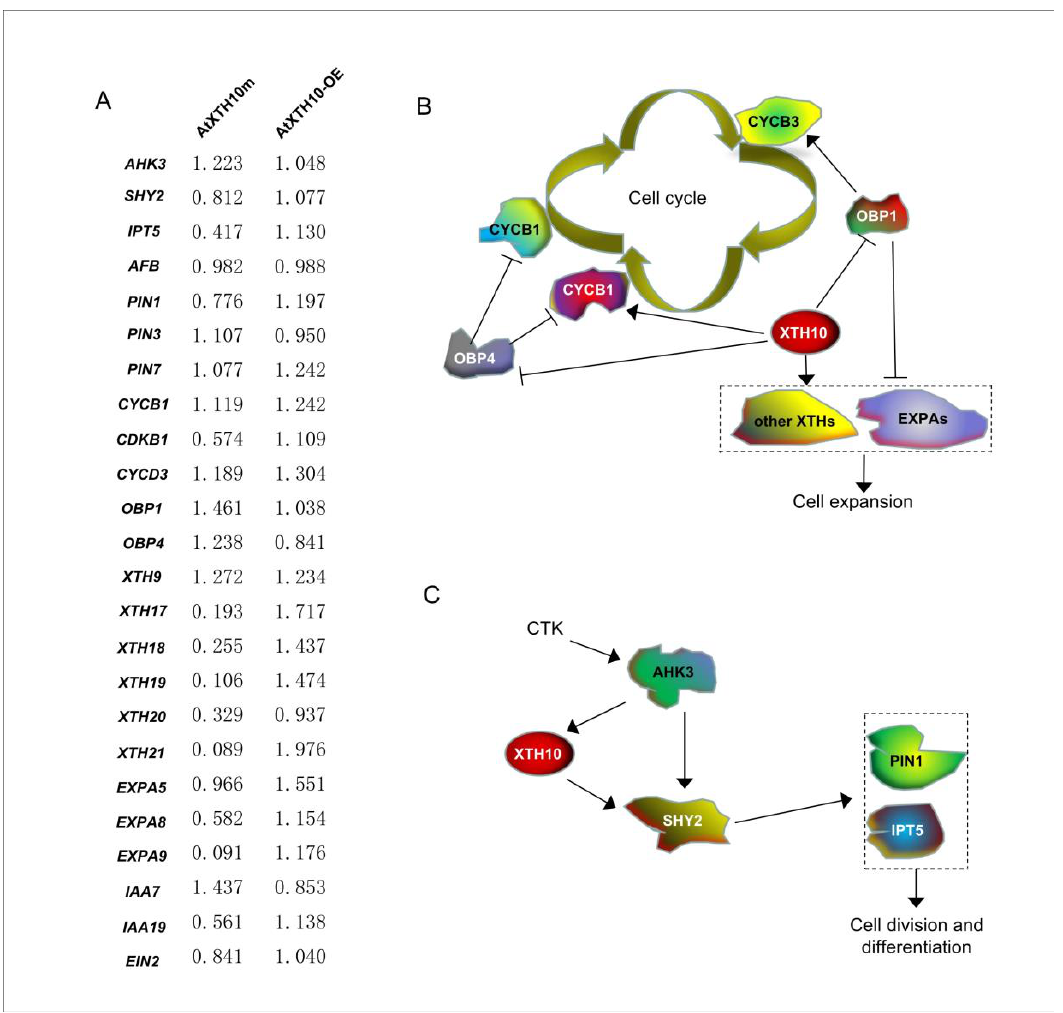
Figure 4. Relative expression levels of the known key genes of root development signal pathway in AtXTH10m and AtXTH10-OE compared with wild type Arabidopsis (Col) plants ( A ). The signal pathway of root cell expansion mediated by cell cycle ( B ). The signal pathway of cytokinin-mediated root division and differentiation ( C ). The graph ( A ) is automatically generated by BAR HeatMapper Tool (http://bar.utoronto.ca) and the depth of color represents the difference of expression. Three biological repeats were performed for this RT-qPCR analysis. Their average relative expression data are marked on the graph.